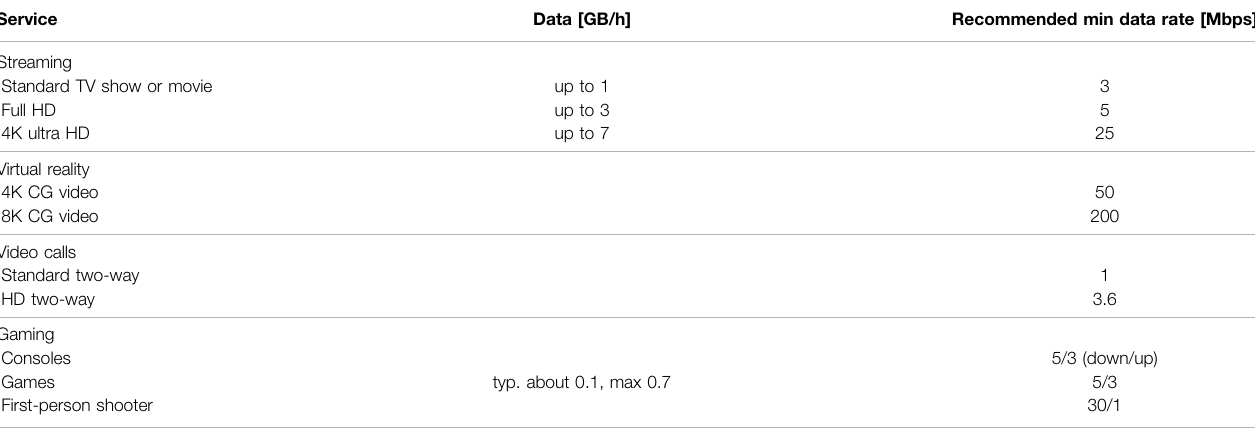
TABLE 1| Exampledataraterequirements, where Bdenotes bytes andHDhigh density. Note thatGB/hcorresponds, onaverage,toa2.2 Mbps datarate.Latency, which is an issue in online gaming, is not addressed herein. Information in the table is from online sources. a,b,c,d,e,f